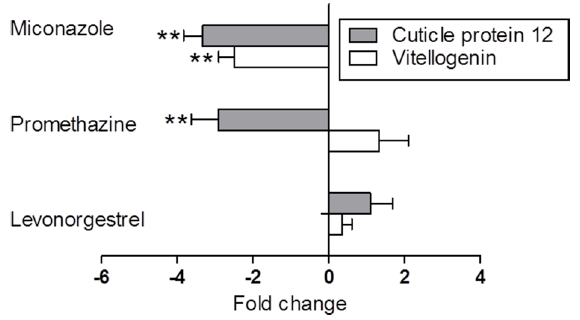
Figure 2. Gene expression changes. Change in gene expression of cuticle protein 12 and vitellogenin for D. magna , instar 3, exposed to miconazole (0.0023 mg L 2 1 ), promethazine (0.059 mg L 2 1 ) or levonor- gestrel (1.02 mg L 2 1 ). The fold change (mean 6 SD; n =3) is shown in relation to the respective controls. Asterisks indicate significance level: p # 0.01 (**) determined by an unpaired